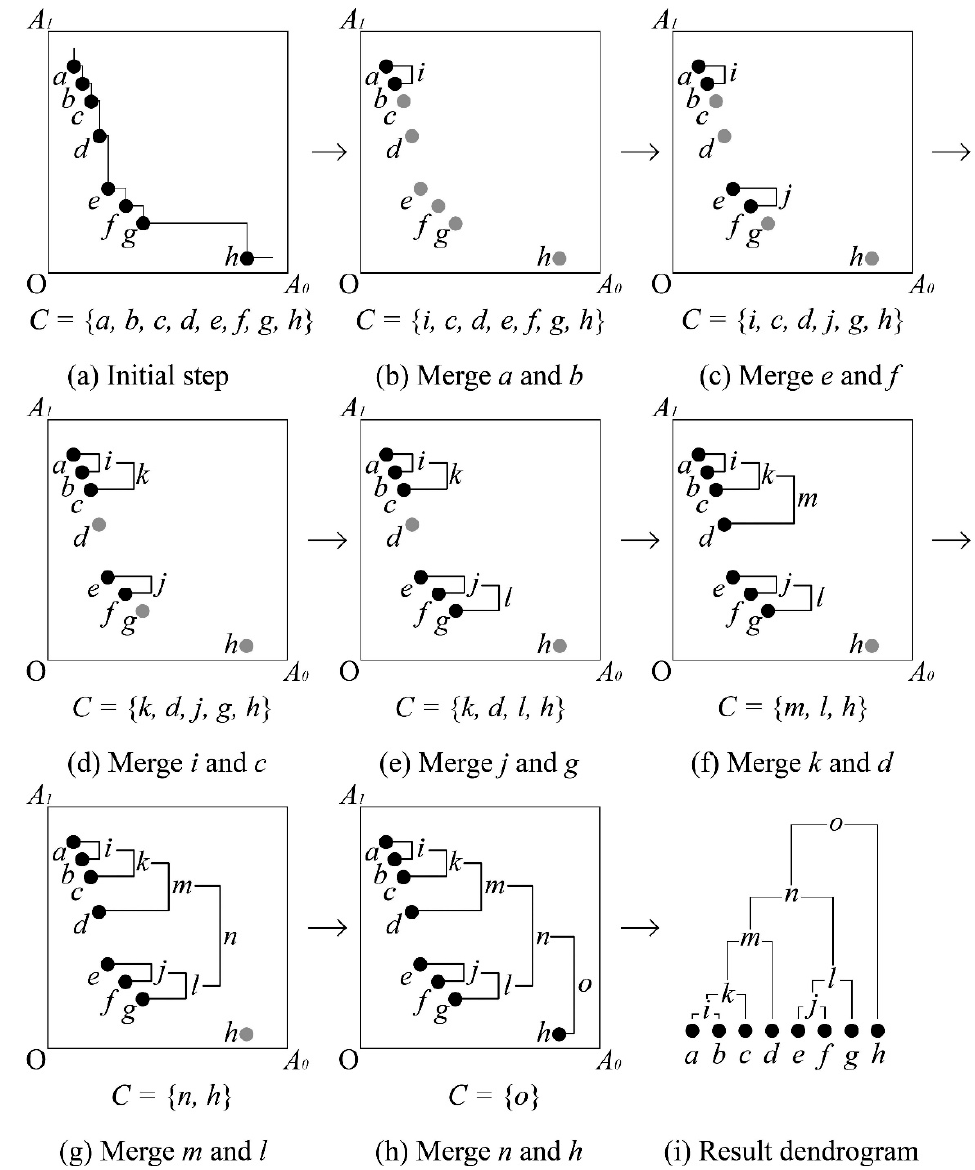
Figure 4. An example of clustering step.